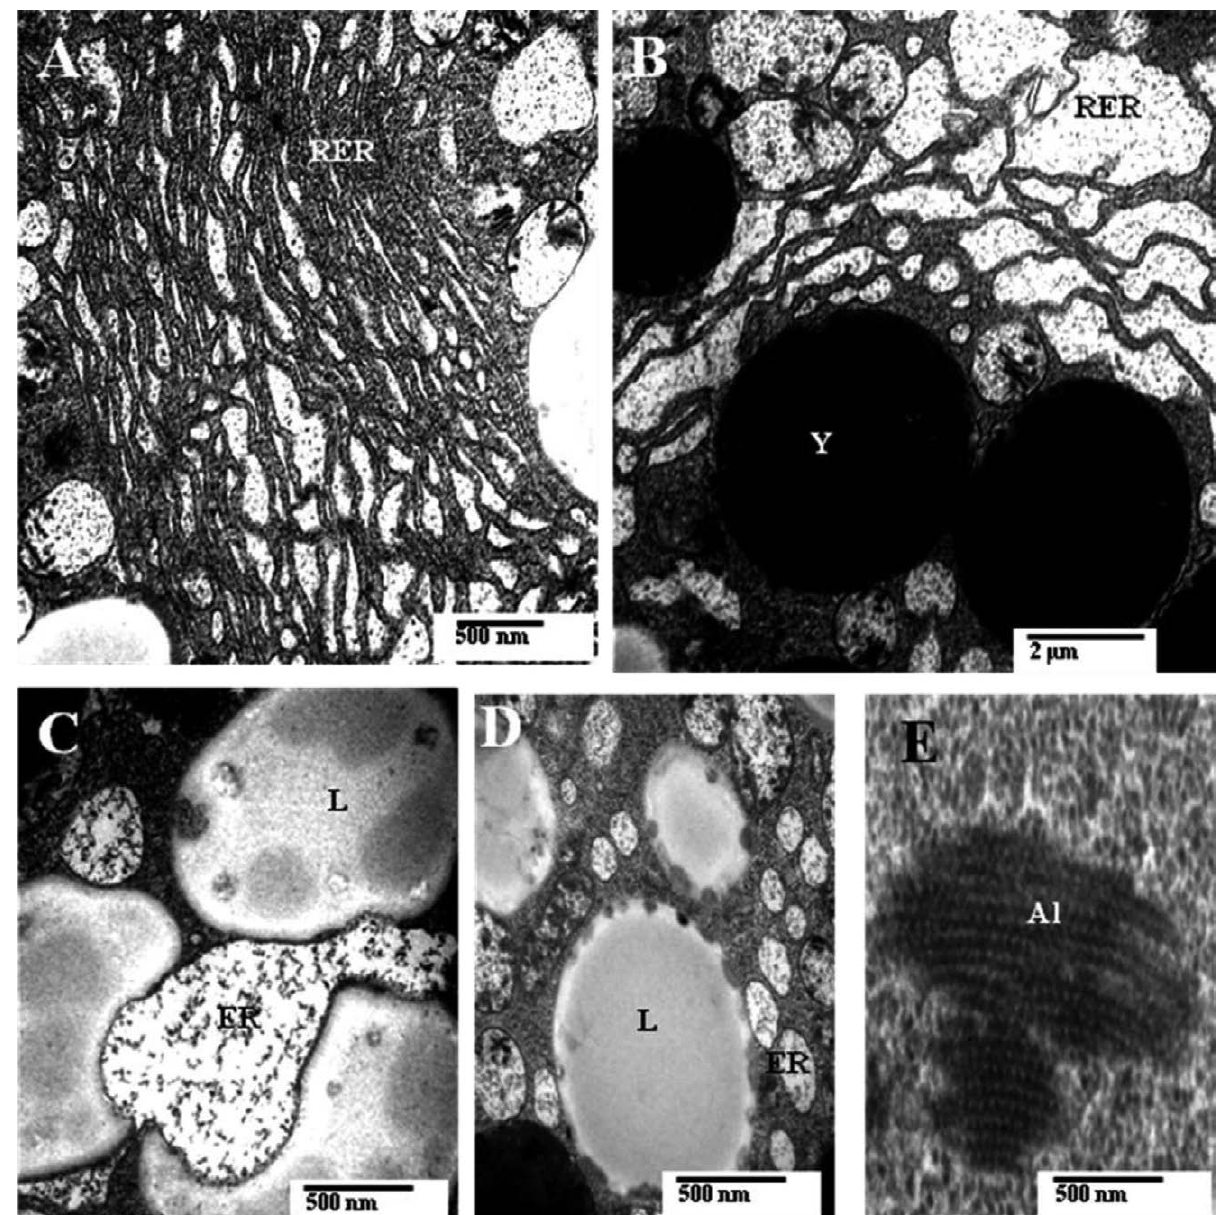
Fig. 9. – A and B, extensive parallel arrays of rough endoplasmic reticulum (RER) in the ooplasm of late vitellogenic oocyte. C and D, ER- membrane cisternae (ER) closely apposed to heterogeneous lipid droplets (L). E, annulate lamellae (Al). Y, yolk